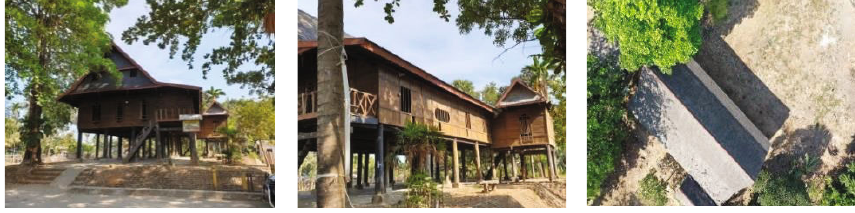
Figure 19: Bola Soba ’ s images.